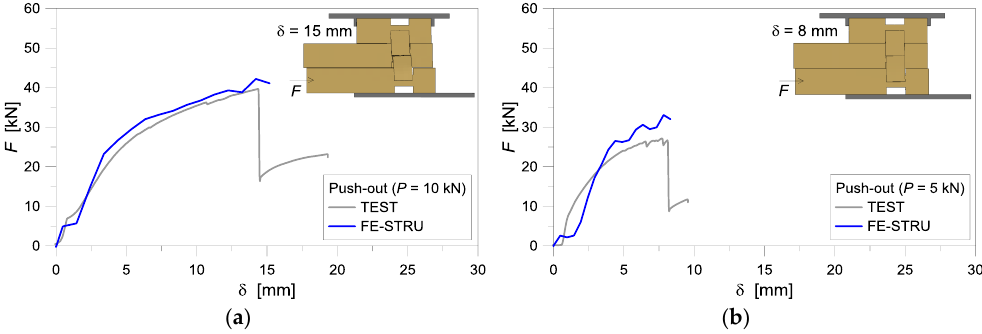
Figure 4. Load-displacement response of Standard joints, as obtained experimentally [12,13] and numerically (ABAQUS), under an assigned preload P of ( a ) 10 kN and ( b ) 5